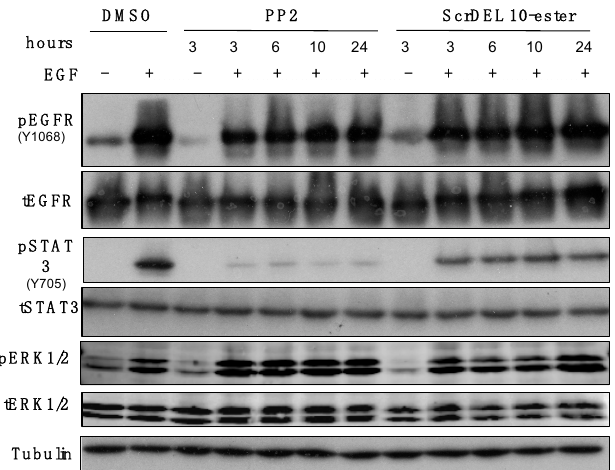
Figure 8. Inhibition of Src-dependent kinase signaling in EGFR-transformed mammary epithelial cells (NME) cells by SrcDEL10 . NME cells were serum deprived for 24 h in the presence of vehicle control (DMSO), Src family inhibitor PP2 (10 µ M), or SrcDEL10-ester (100 µ M) for the indicated amounts of time. Where indicated, these cells were subsequently stimulated with epidermal growth factor (EGF) (50 ng / mL) for an additional 30 min. Equal protein aliquots were analyzed by immunoblot with the indicated antibodies. Data are representative of at least 3 independent experiments.